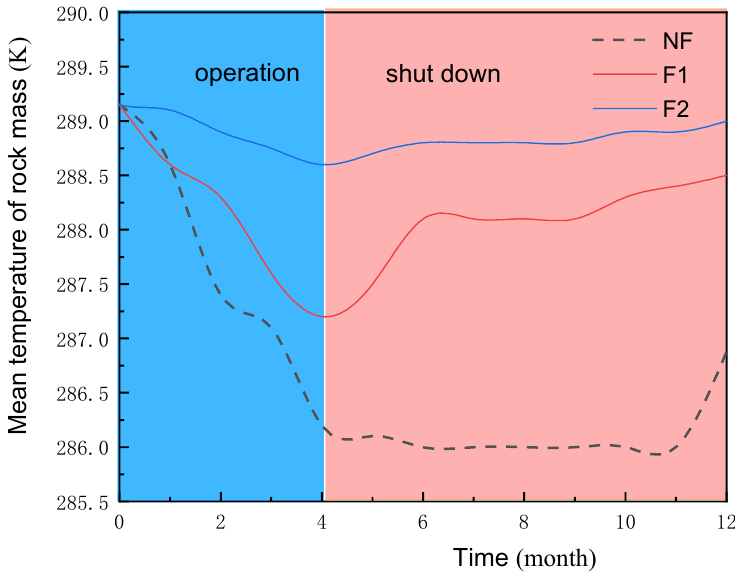
Figure 12. Mean temperature of the rock mass in one operation–shutdown circle. NF is the non- fracture case, F1 is the one horizontal fracture case, and F2 is the two horizontal fractures case.